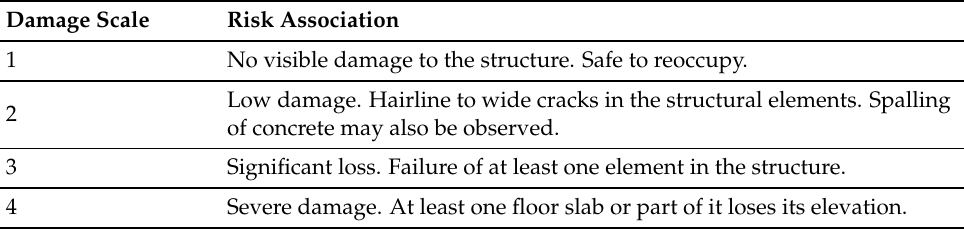
Table 2. Damage scales associated with various risk factors.